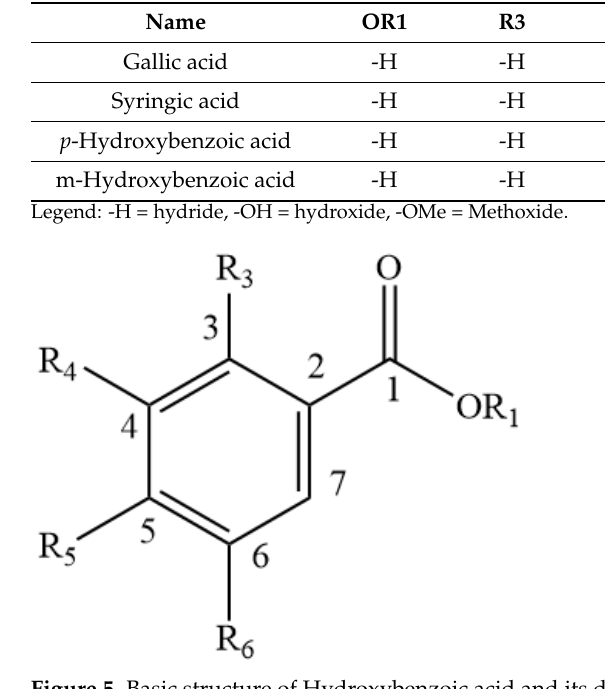
Figure 5. Basic structure of Hydroxybenzoic acid and its derivatives.